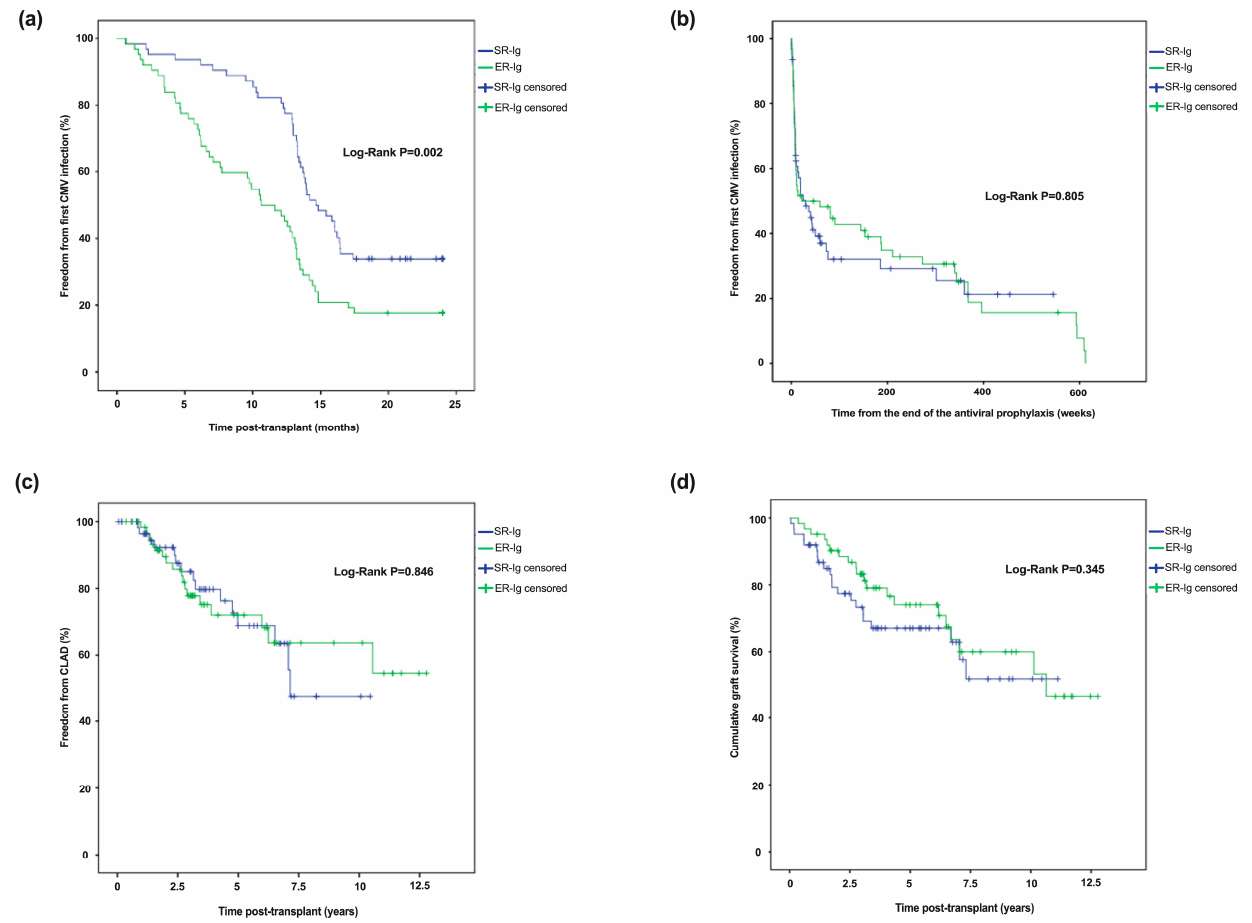
Figure 1. Kaplan-Meyer analyses of ( a ) time first CMV infection; ( b ) cumulative risk of first CMV infection off antiviral prophylaxis; ( c ) time to CLAD; and ( d ) survival in patients receiving short or label use CMV-Ig prophylaxis (SR-Ig) compared to patients receiving extended CMV-Ig regimen